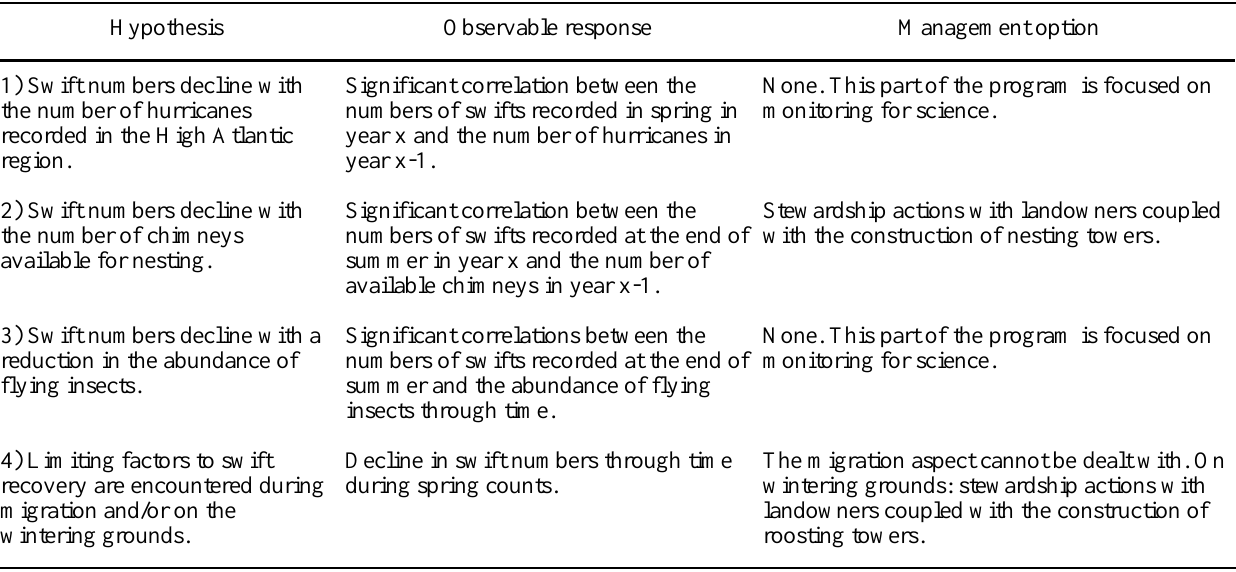
Table 2. Hypotheses developed for the state of the Chimney Swift ( Chaetura pelagica ) population in Québec and the observable responses according to each